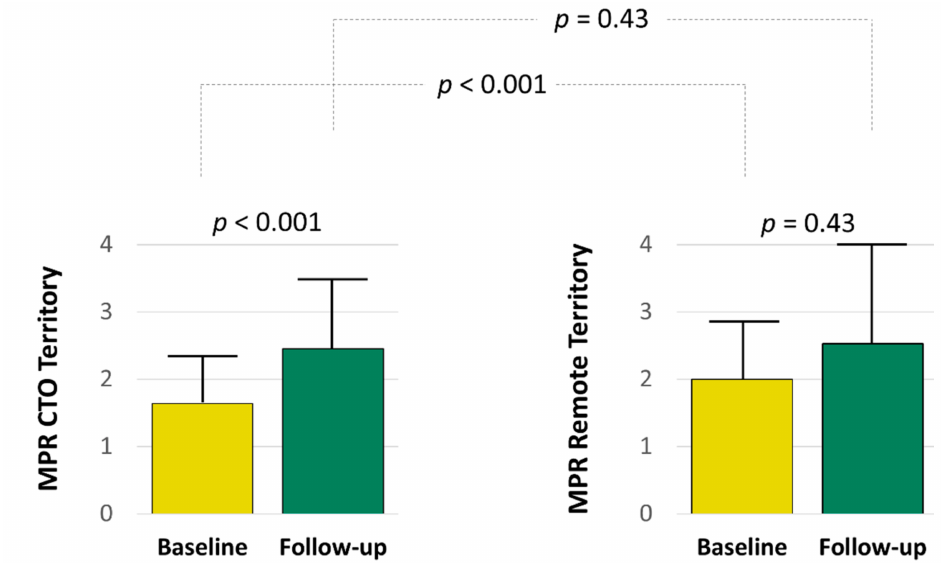
Figure 2. Cardiovascular magnetic resonance findings: myocardial perfusion reserve. Abbreviations: CTO, chronic total occlusion; MPR, myocardial perfusion